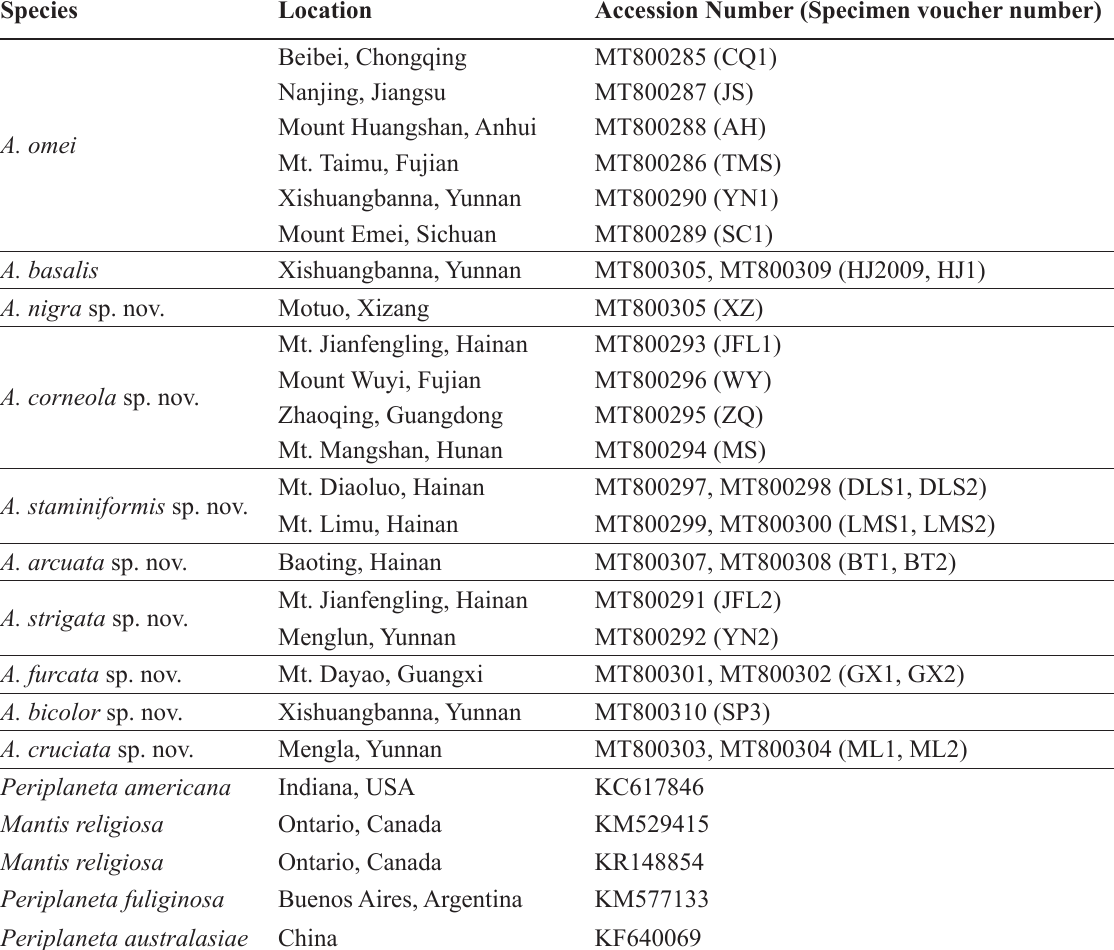
Table 1. Samples used in species delimitation: sample collection localities, specimen voucher, and GenBank accession